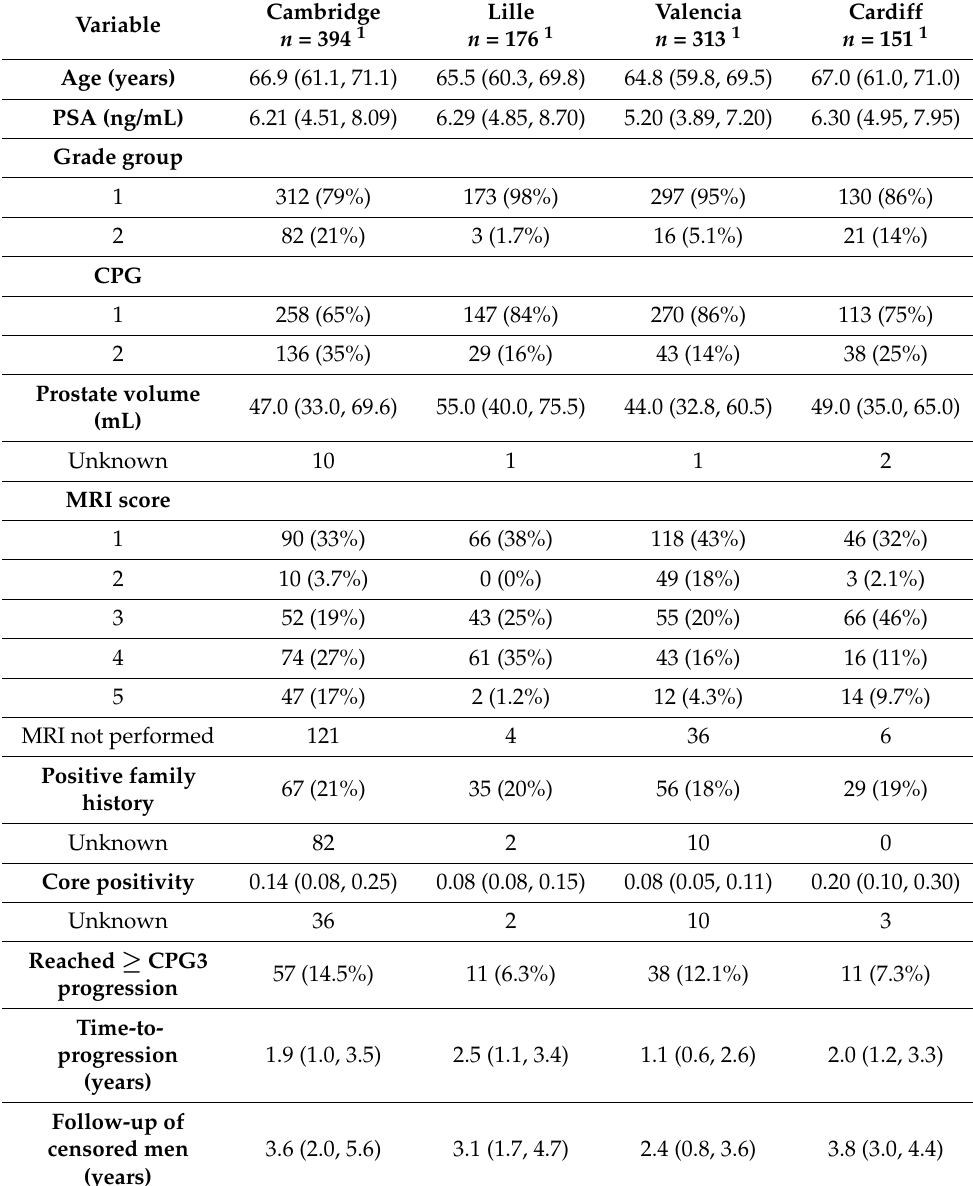
Table 2. Summary cohort characteristics including diagnostic baseline parameters and surveil- lance outcomes, stratified by location. The multicentre model development cohort comprised men from Cambridge, Lille, and Valencia. The Cardiff cohort was used for external validation. CPG, Cambridge Prognostic Group; PI-RADS, Prostate Imaging-Reporting and Data System; PSA, prostate- specific